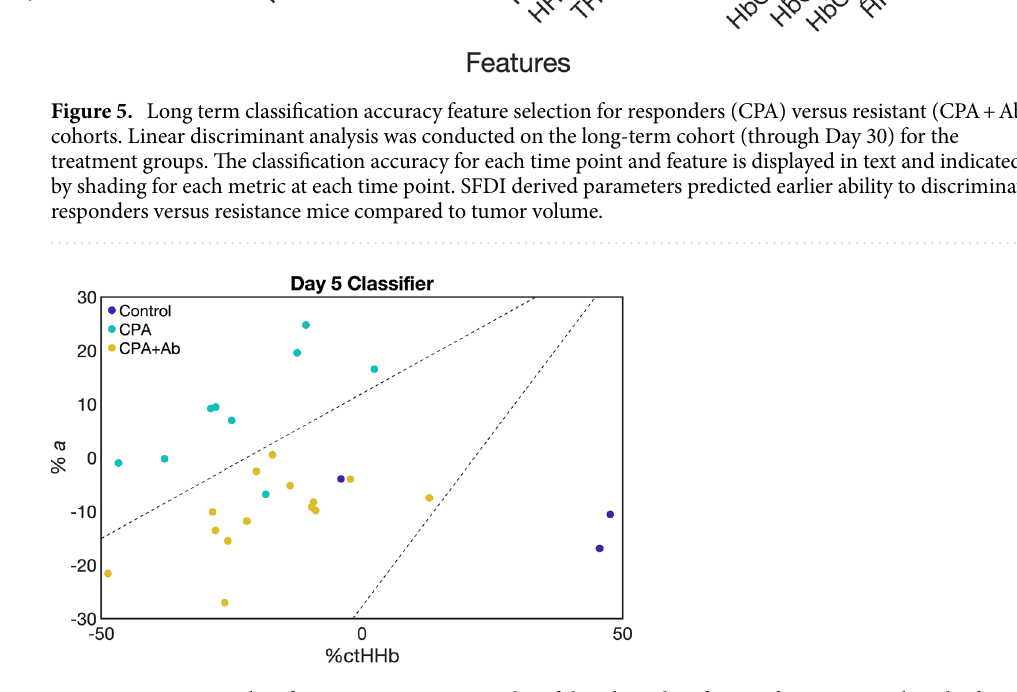
Figure 6. 2 Feature Classification at Day 5. Scatterplot of the 2 best classification features: ctHHb and a for individual mice. The color of the individual points indicates its respective treatment: Control (purple), CPA (blue), CPA + Ab (yellow). The dashed lines indicate the calculated lines of separation between the different treatment